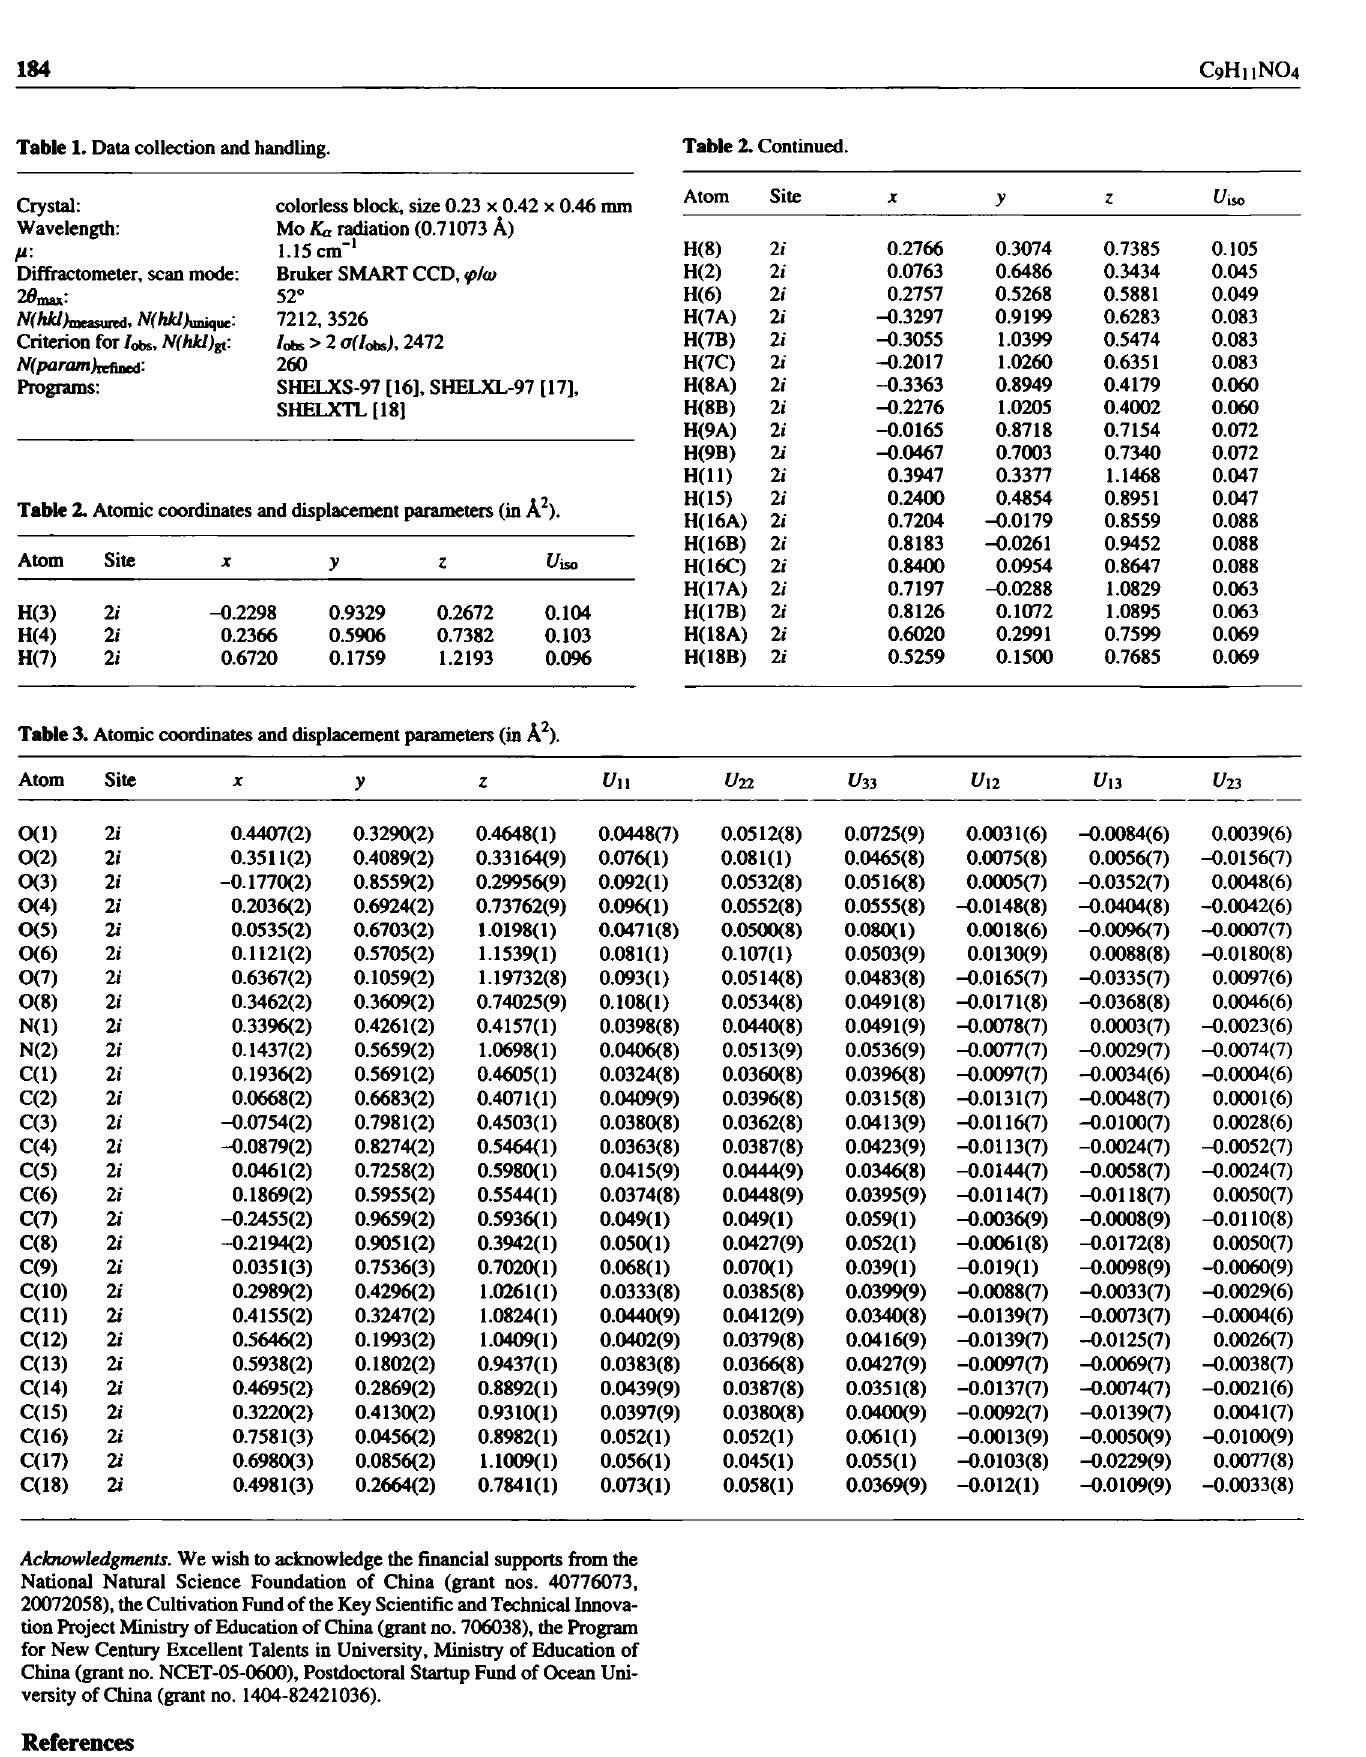
Table 1. Data collection and handling.